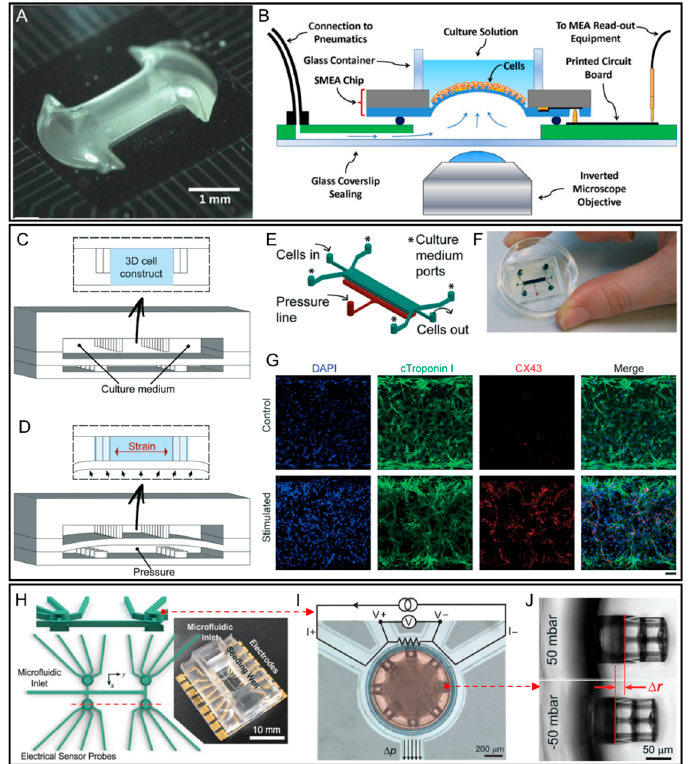
Figure 1. Heart-on-a-chip platforms with microfluidic actuators. ( A ) Photograph of the SMEA chip inflated with 15 kPa air pressure. ( B ) Schematic illustration of the SMEA chip system with a multi- layered configuration. Reproduced with permission from [48]. ( C ) Design of the 3D heart-on-a-chip microdevice proposed by Marsano et al. The device uses two compartmentalized PDMS microcham- bers separated by a PDMS membrane. ( D ) Deflection of the PDMS membrane by pressurizing the bottom compartment for producing a uniaxial strain to the 3D cell construct. ( E ) A 3D sketch of the channel design. ( F ) A picture of the actual heart-on-a-chip device. ( G ) Immunofluorescent images of specific cardiac markers such as cardiac troponin I (green) and gap junctions (connexin 43, red) of mechanically stimulated neonatal rat cardiac cells with or without stimulation (nuclei are stained by DAPI in blue), showing the effectiveness of cyclic mechanical strain on micro-cardiac construct maturation. Reproduced with permission from [50]. ( H ) Design and actual image of the platform fabricated using direct laser writing. ( I ) False-colored image showing a device with con- necting microchannels: Seeding well with cardiac microtissue (red) and annular connecting micro- channels (light blue). The top region of the annular microchannel acts as the electrical sensor. ( J ) Actuation of a cell-attachment site “cage” upon the application of pressure. Reproduced with per- mission from [52].